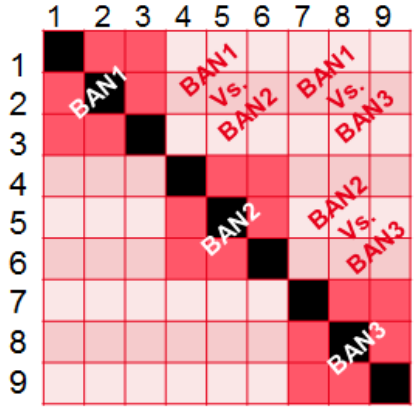
Figure 5. Link condition matrix for each link